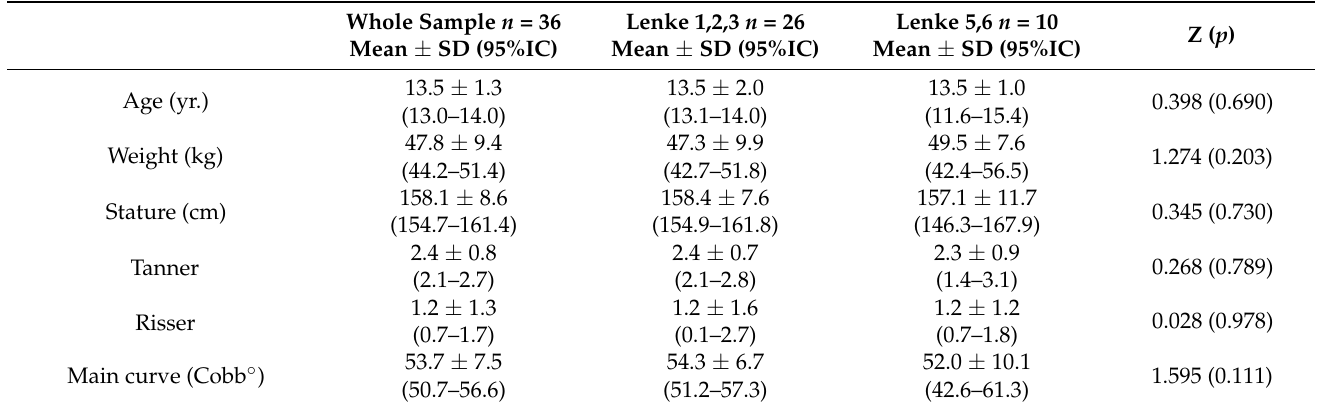
Table 1. Clinical profile and characteristics of the